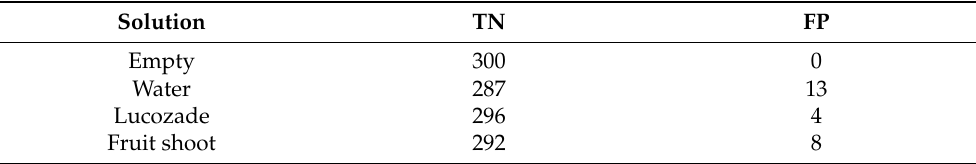
Table 3. Classification of safe substances scanned through the walls of PET and HDPE bottles using Model 1. TN = True Negatives and FP = False